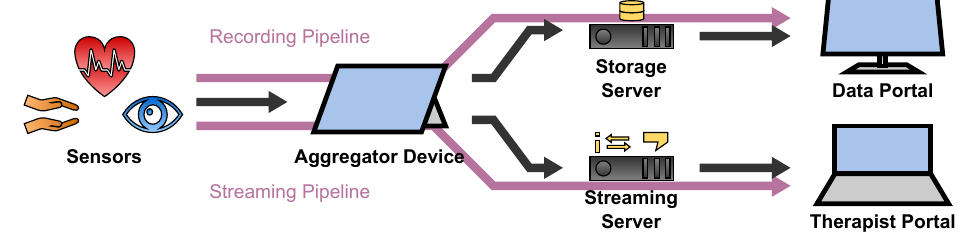
Figure 2. Overview of the sensor transport